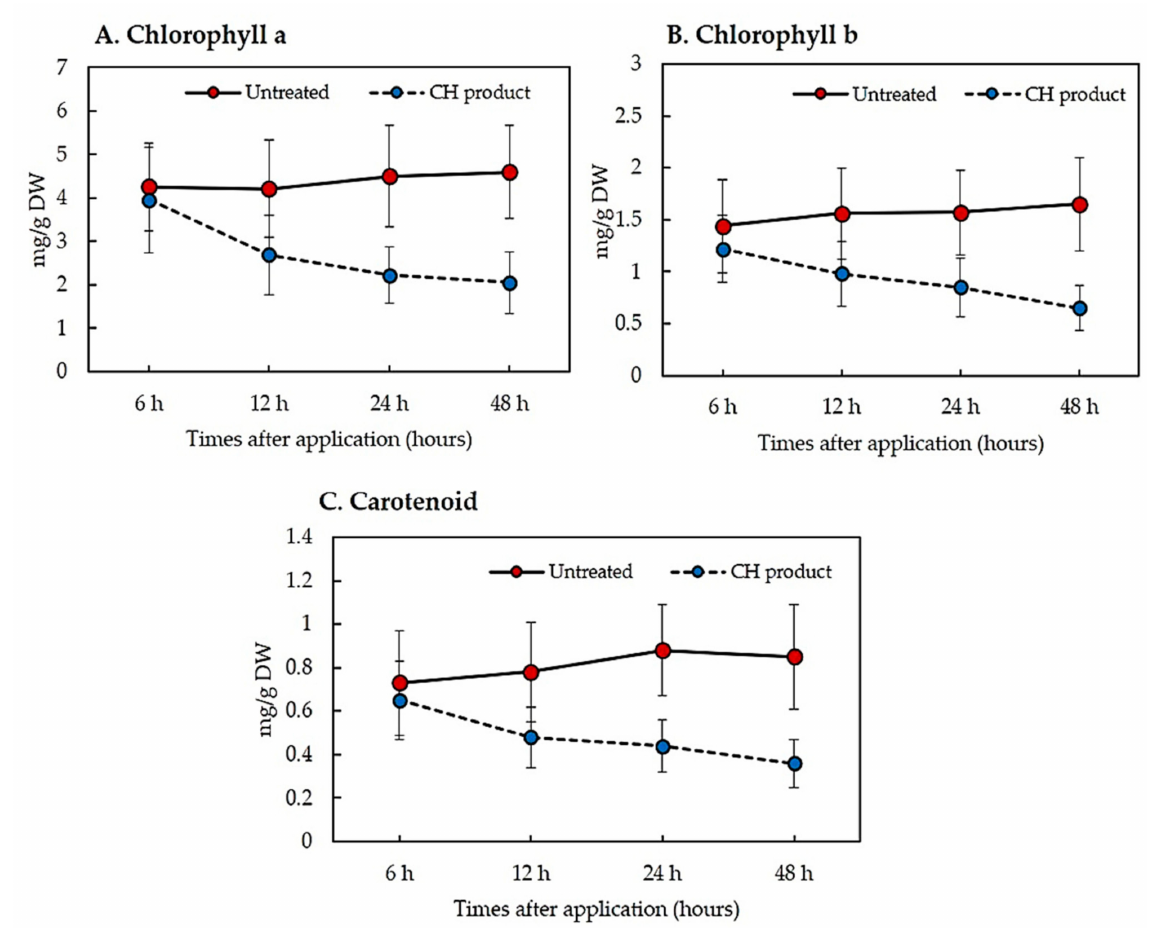
Figure 6. The amounts of chlorophyll a ( A ), chlorophyll b ( B ), and carotenoid ( C ) contents in E. crus-galli leaf at increasing times after post-emergence spray application of CH product under pot experiment in glasshouse conditions. Means expressed error bar ( ± SE) with four